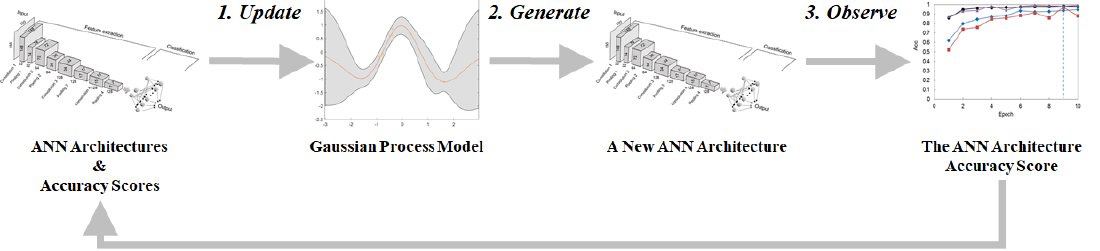
Figure 5. Illustrative Example of Bayesian Optimization Process for NAS.